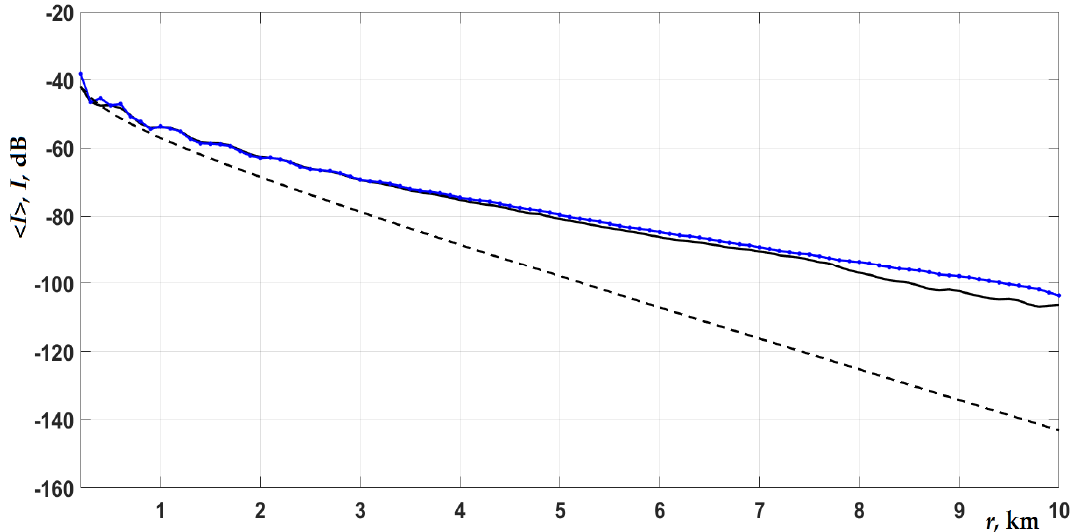
Figure 7. Comparison of the average intensity I in waveguides with a random field c 1 ( z , r ) and c 1 ( r ). H = 30 m, z = z 0 = 14 m. The marker curve corresponds to a waveguide with a random process c 1 ( r ) (Figure 3), the solid black curve corresponds to a waveguide with a random field c 1 ( z , r ) (Figure 6). These curves describe the OW solution (2)–(5). The lower curve is a deterministic solution (see Figure 3).